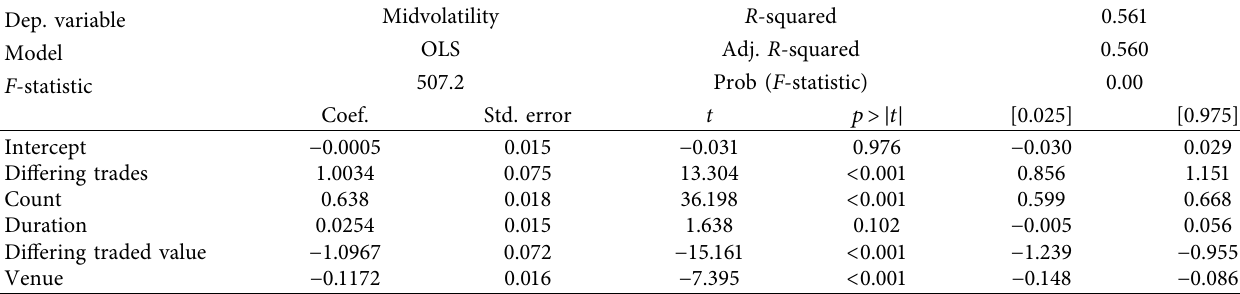
Table 2: Linear regression diagnostics for midvolatility as a function of trade statistics, dislocation statistics, and venue fluctuation. Dep. variable